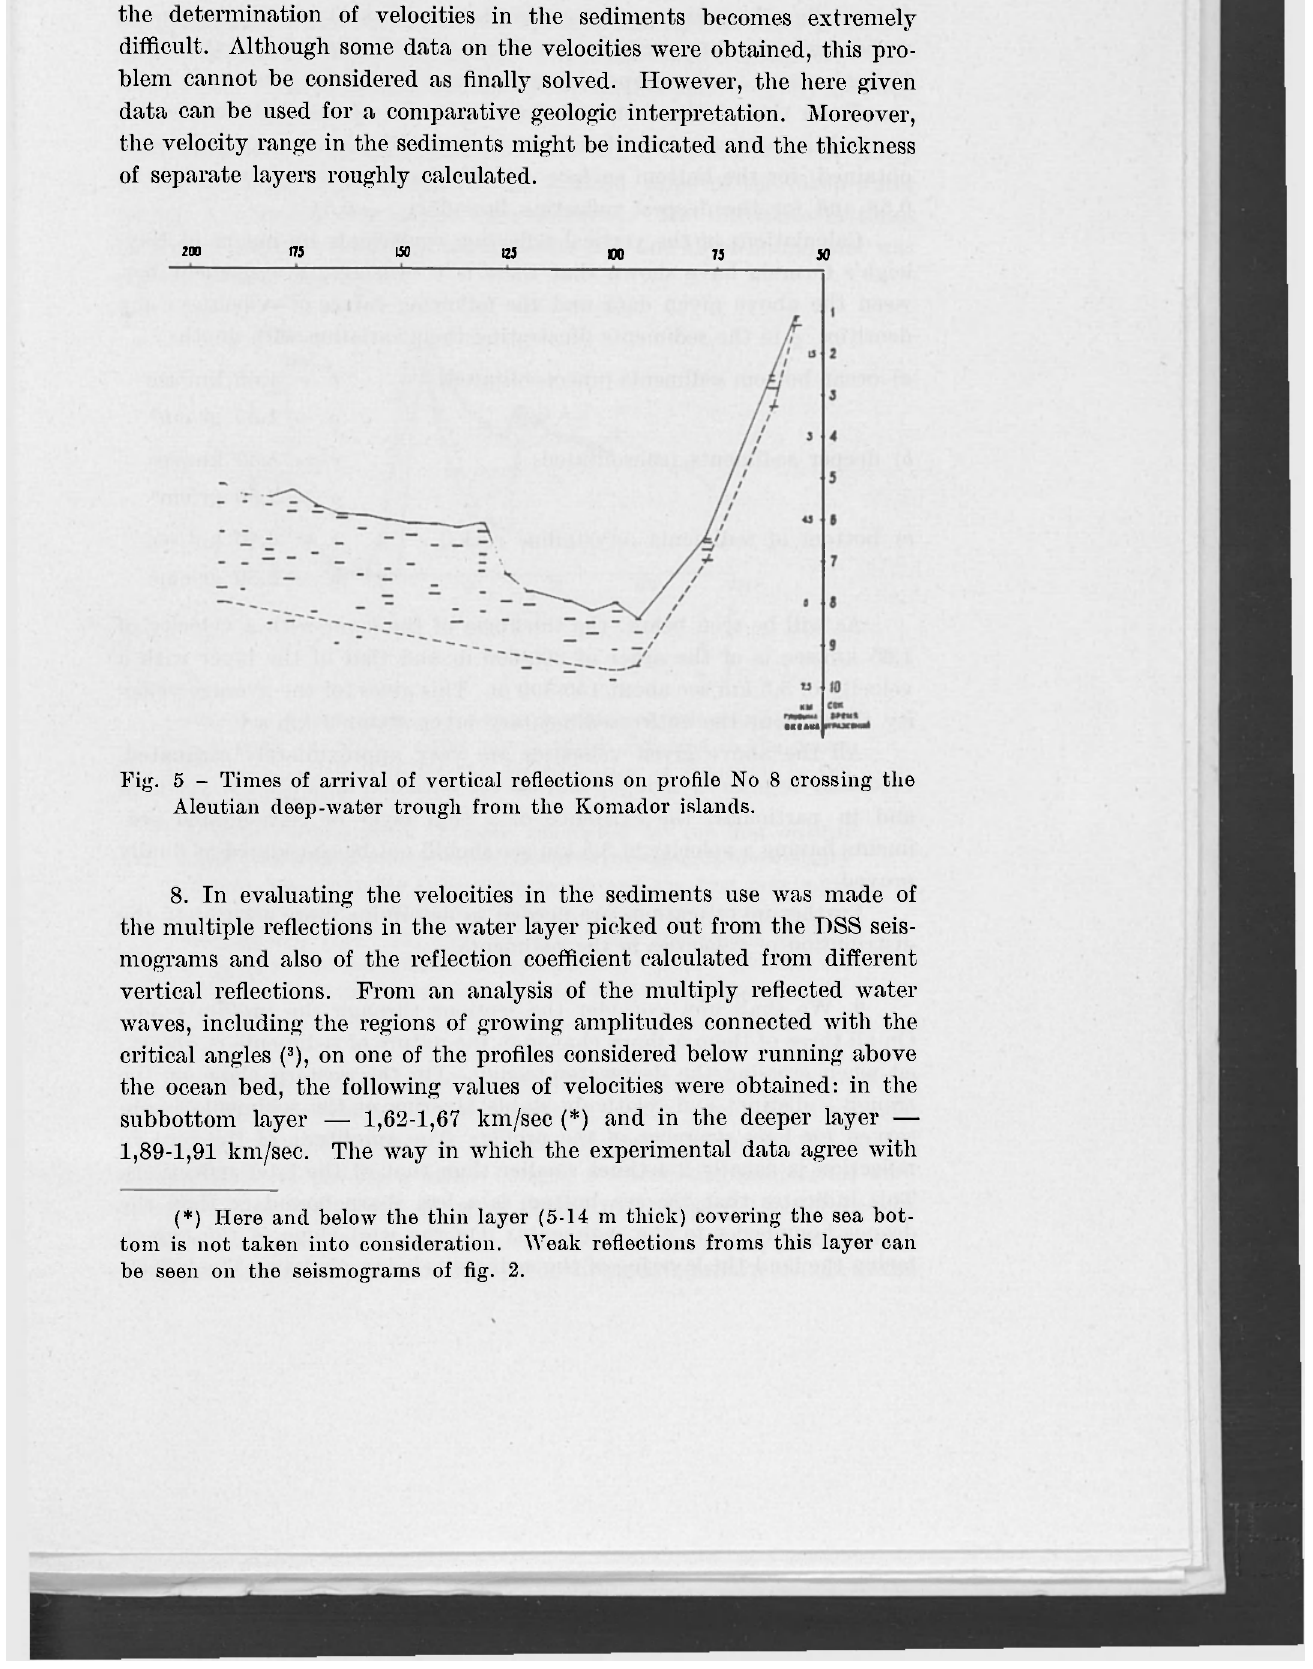
Fig. 5 - Times of arrival of vertical reflections on profile No 8 crossing the Aleutian deep-water trough from the Komador islands.